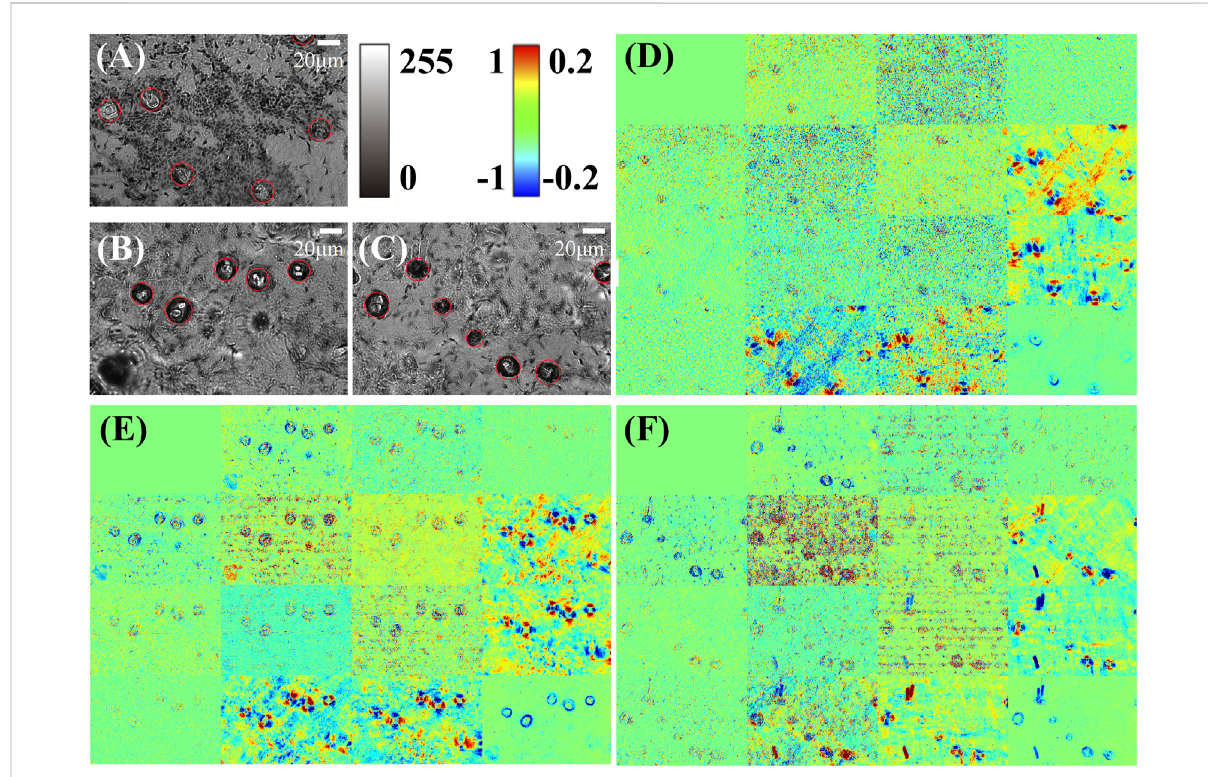
FIGURE 2 Mueller matrix microscopic imaging results of three mouse skin tissue sections and the original grayscale intensity images. (A – C) are the microscopic grayscale images of the three samples, in which the hair follicles are identi fi ed and marked by red circles. (D – F) are the Mueller